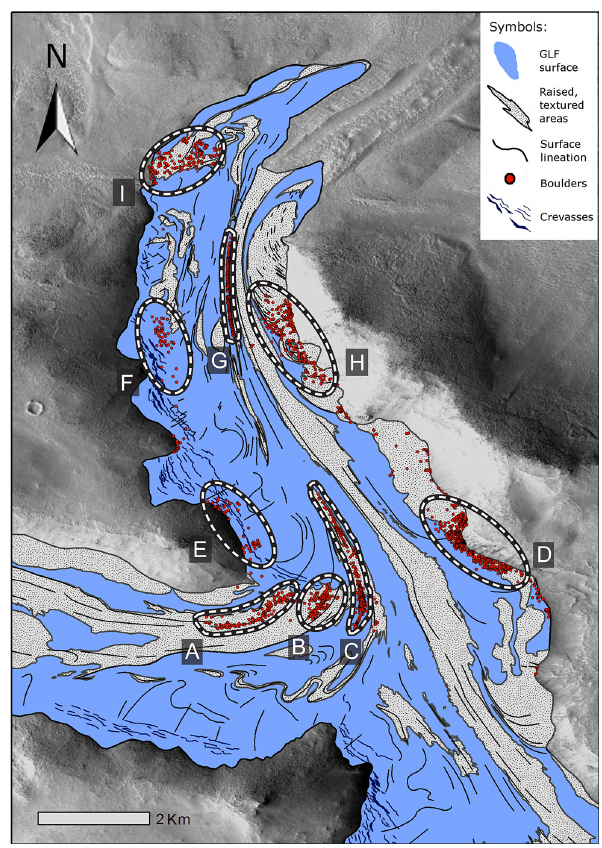
Figure 9. Geomorphological map and interpretation of boulder clusters A–I located on the surface of GLF #498, illustrated in Fig.